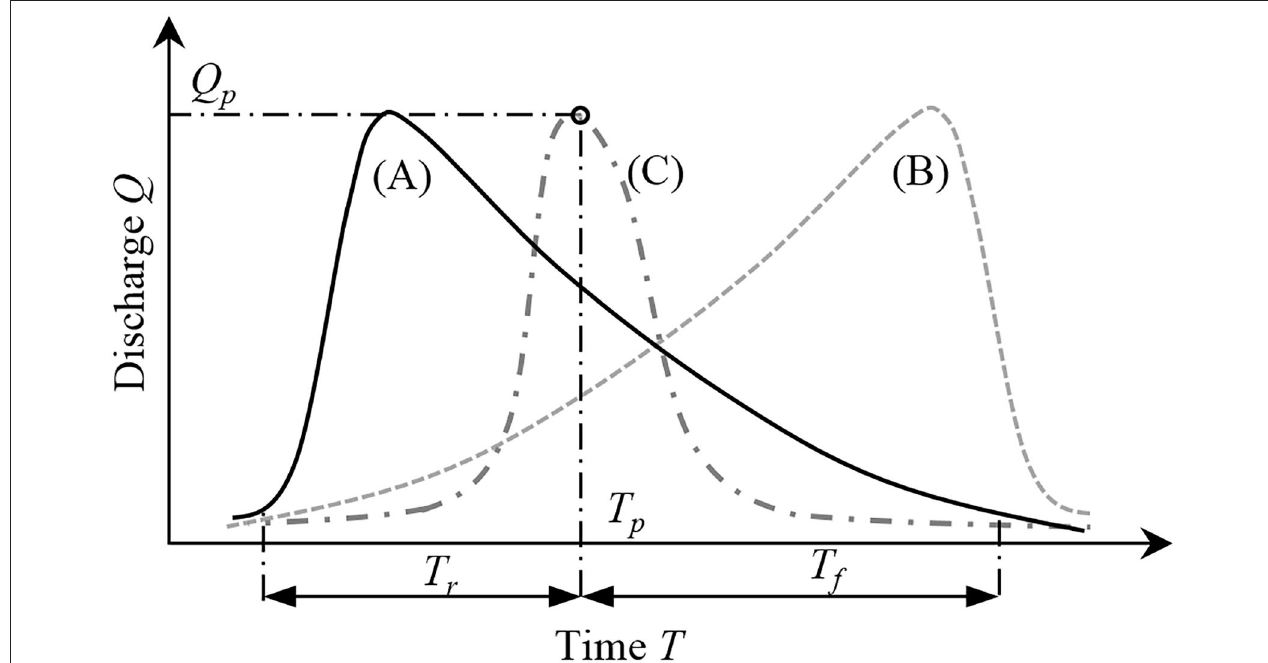
FIGURE 8 | A sketch of the typical patterns of hydrographs of breach floods.